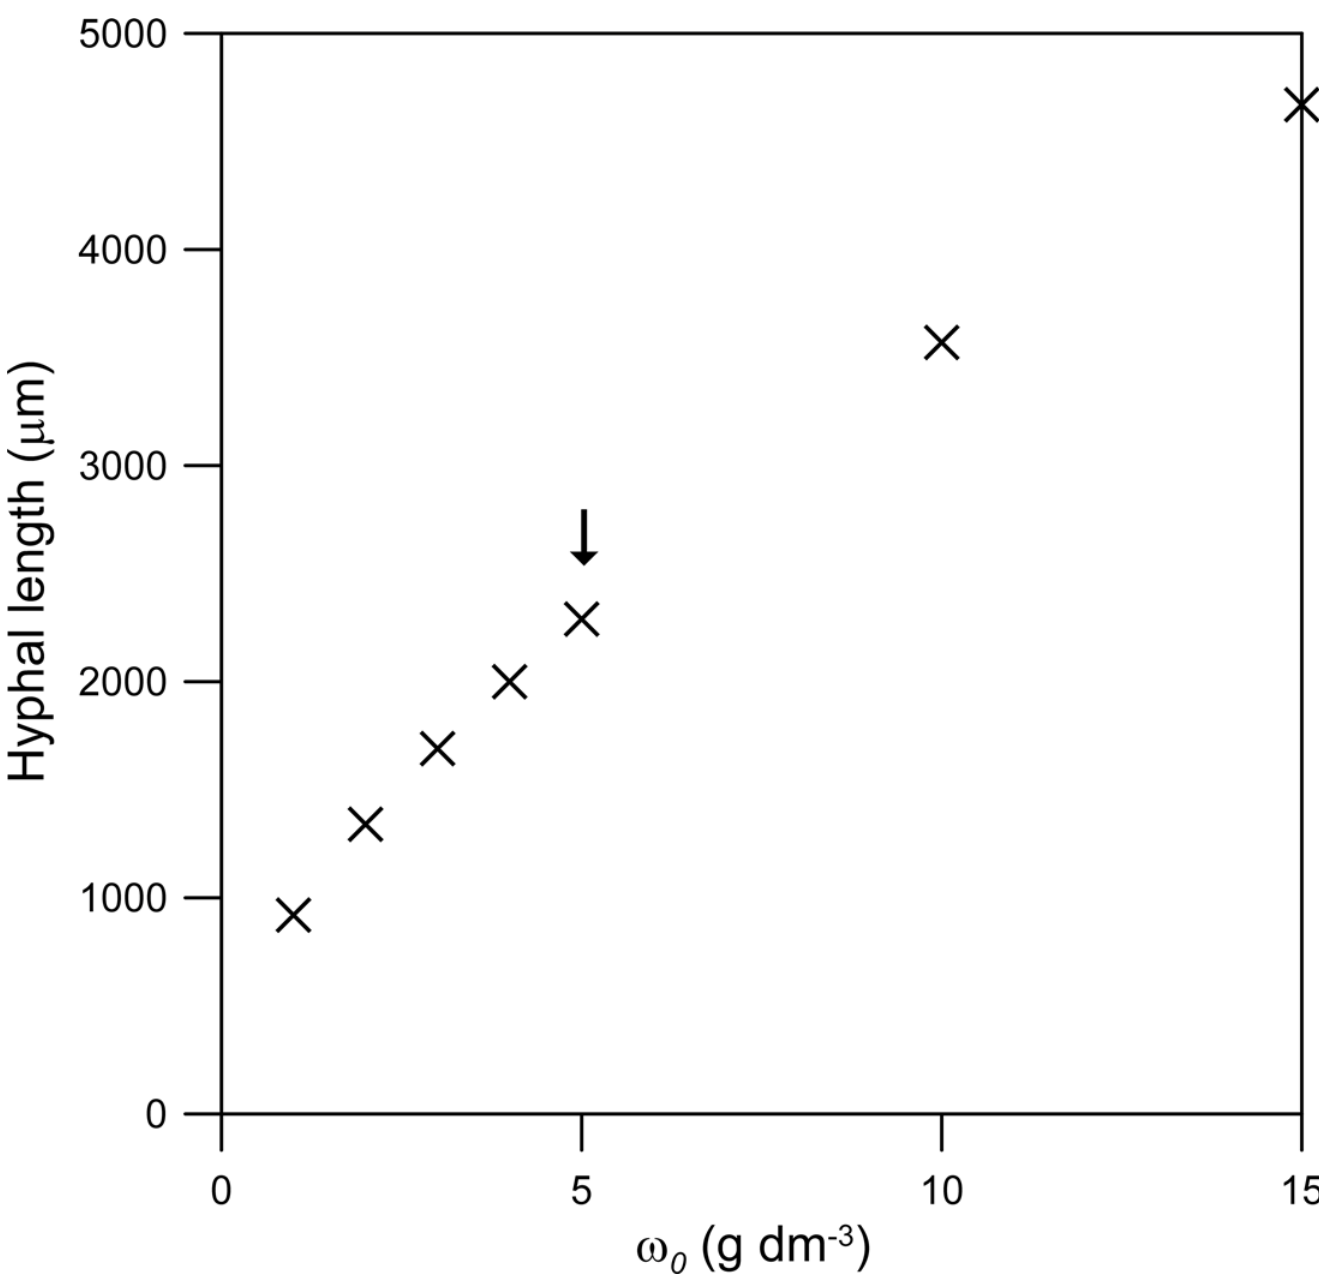
Fig 6. Effect of the concentration of nutrients in the source tank ( ω 0 ). The comparison is based on the hyphal length reached at 24 h. The original value (i.e. that used for Figs. 3A and 4) is indicated with an arrow. The initial values of the variables and the other parameter values are as listed for Rhizopus oligosporus in Table